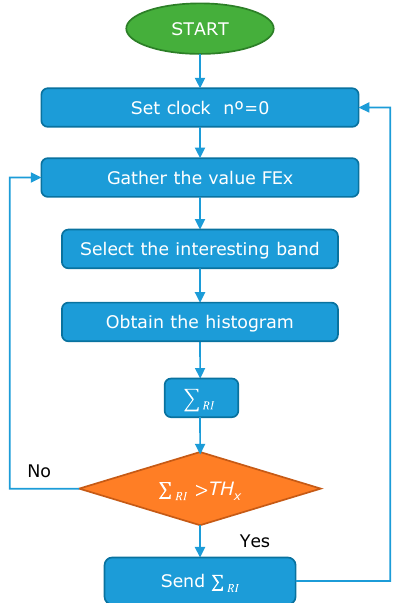
Figure 5. Operation algorithm for feed falling sensor.